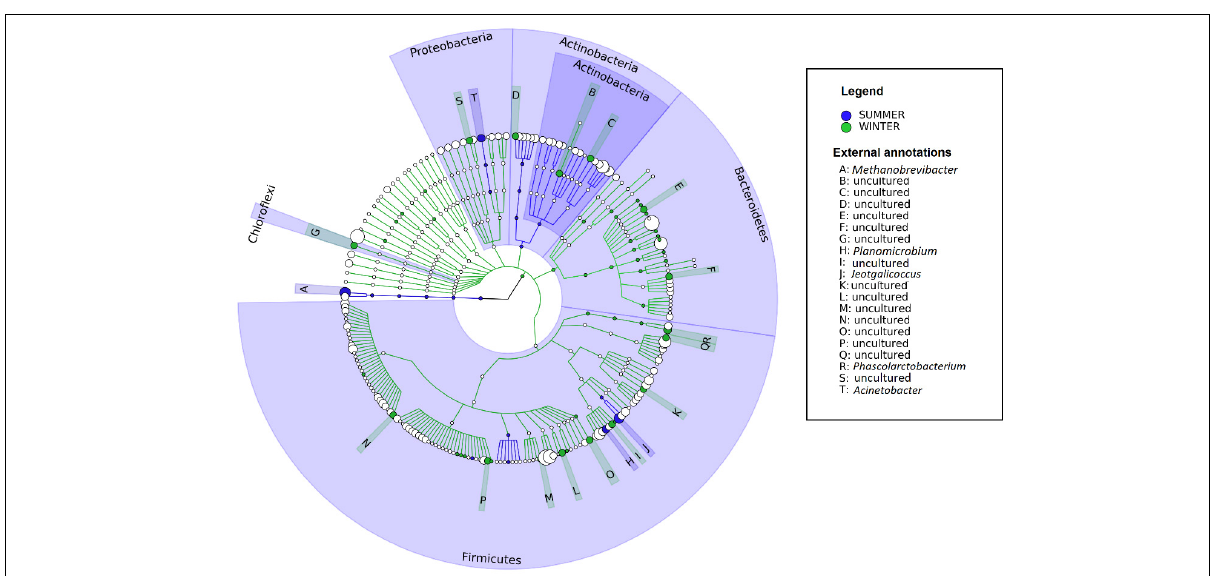
Figure 6: Differentially abundant bacterial phylotypes of Zulu sheep faeces between summer and winter. Rings (from inside out) 1,2,3,4,5 and 6 are the domain, phylum, class, order, family and genus taxonomic ranks, respectively. Only features with a linear discriminatory analysis value > 2.0 are